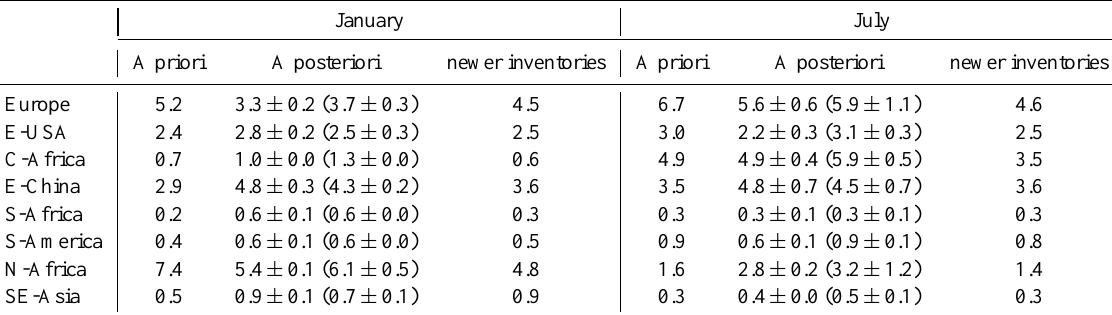
regional emissions obtained from the a priori emissions, the newer inventories (EDGAR version 4.2, GFED version 3.1, and GEIA), and those optimized from the full assimilation run and the emission inversion run (in bracket) are